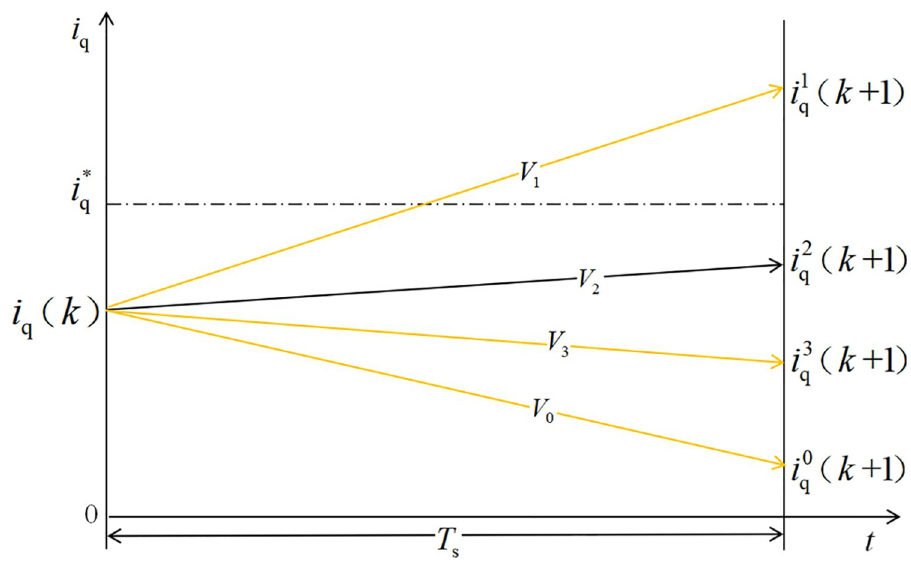
Fig 2. Schematic showing the traditional MPCC vector selection procedure.